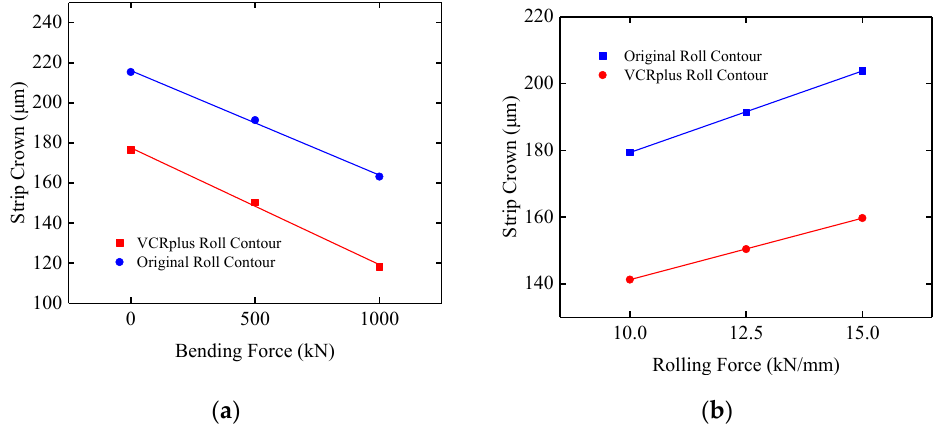
Figure 14. ( a ) Bending force control effect; ( b ) roll gap transverse stiffness.